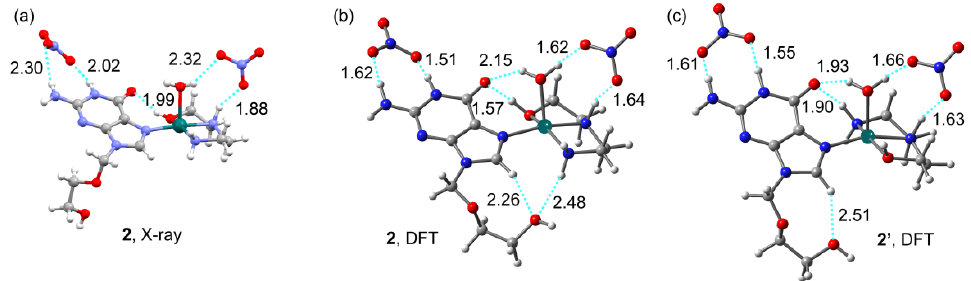
Figure 3. ( a ) X-ray structure of compound 2 ; ( b ) B3LYP-D3/def2-SVP optimized geometry of 2 ; ( c ) B3LYP-D3/def2-SVP optimized geometry of 2 ′ (see text). H-bonds are depicted in black dashed lines. Distances in Å. Atoms colour code: carbon—grey; hydrogen—white; nitrogen—blue; oxygen—red; copper—dark green.